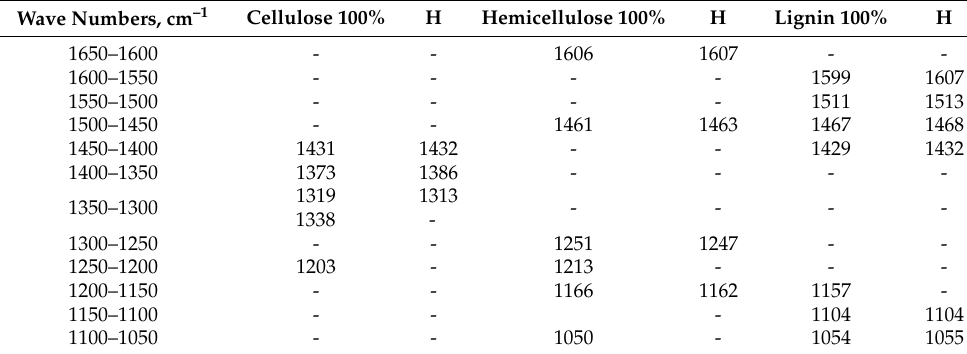
Table 2. Characteristic peaks of pure cellulose, hemicellulose, lignin and cellulose, hemicellulose and lignin in hop (H) residue.